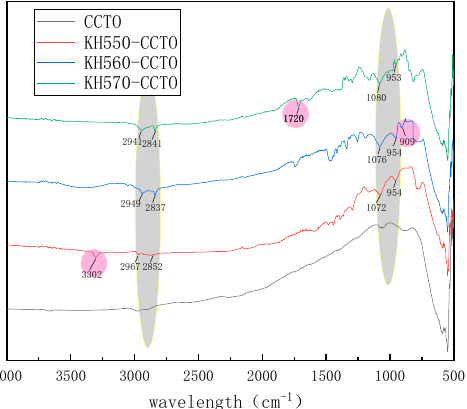
Figure 6. Infrared spectra of unmodified CCTO and modified CCTO.